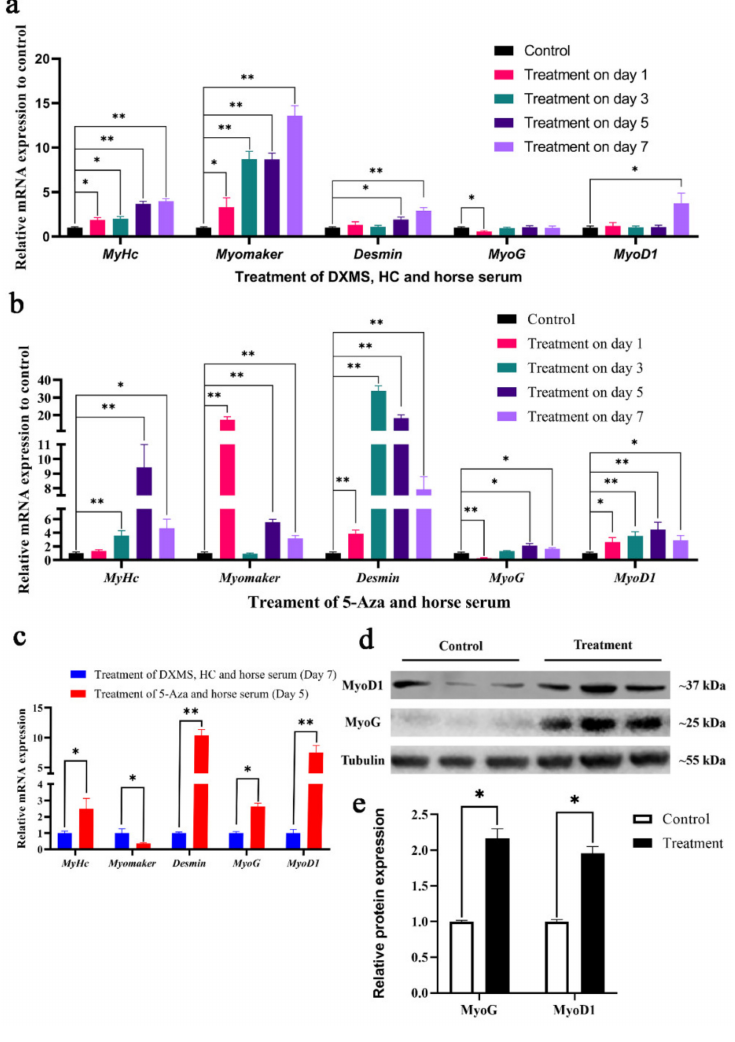
Figure 5. Induction of myogenic differentiation in chicken BM-MSCs under different inductive agents. Muscle-related genes were detected using qRT-PCR after ( a ) DXMS and HCor and ( b ) 5-Aza treatment for 1 day, 3 days, 5 days, or 7 days. ( c ) Based on the qRT-PCR data, the 5-Aza-treated group showed a better myogenic effect in comparison with the DXMS-HC-treated group. ( d ) Western blot results showed that MyoD1 and MyoG were significantly upregulated with the treatment of 5-Aza for 5 days. ( e ) Myogenic protein expression assessed by Western blot analysis is expressed relative amount to Tubulin. Symbol “*” and “**” indicate a significant difference at p < 0.05 and p < 0.01,